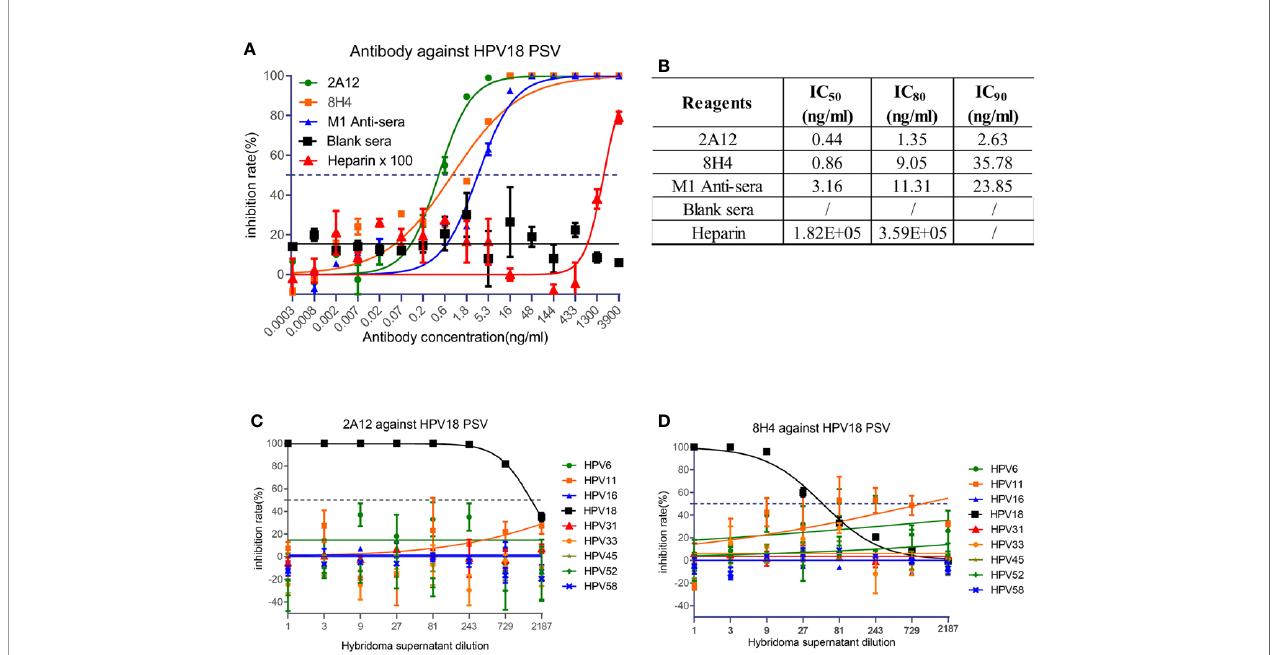
FIGURE 4 | Neutralization activity of 2A12 and 8H4. (A) Neutralization activity of mAbs and mouse sera against HPV18 pseudovirus infection. Heparin was taken as a positive control and heparin ×100 represents that the concentration of heparin in use is the indicated concentration at X axis multiply 100 fold. (B) Summary of the neutralization titers (IC 50 , IC 80 and IC 90 ) against HPV18 pseudovirus infection. Neutralization activity of 2A12 (C) and 8H4 (D) against the pseudovirus infection of various HPV subtypes. Data represent mean ± SEM. All experiments were repeated